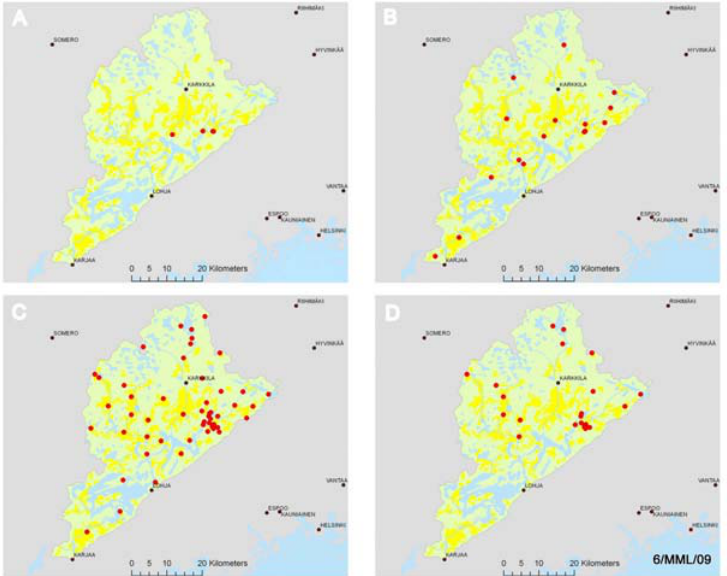
Figure 2. The location of the different SoilWeather WSN stations and sensors in the Karjaanjoki river basin. (a) Nutrient measurement stations. (b) Water turbidity sensors. (c) Weather stations. (d) Soil moisture